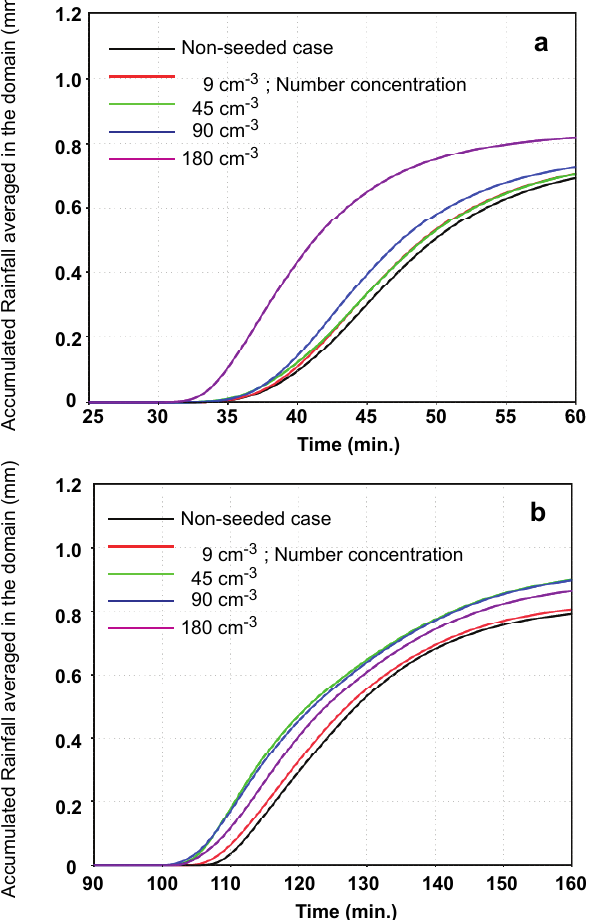
Fig. 10. Temporal change in accumulated surface rainfall averaged over the domain for the shallow convective cloud case (a) and strat- iform cloud case (b) . The black line indicates accumulated surface rainfall for the non-seeded case. For seeded cases, different total number concentrations of salt micro-powder are seeded under the cloud base: 9cm − 3 (red line), 45cm − 3 (green line), 90cm − 3 (blue line), or 180cm − 3 (purple line).